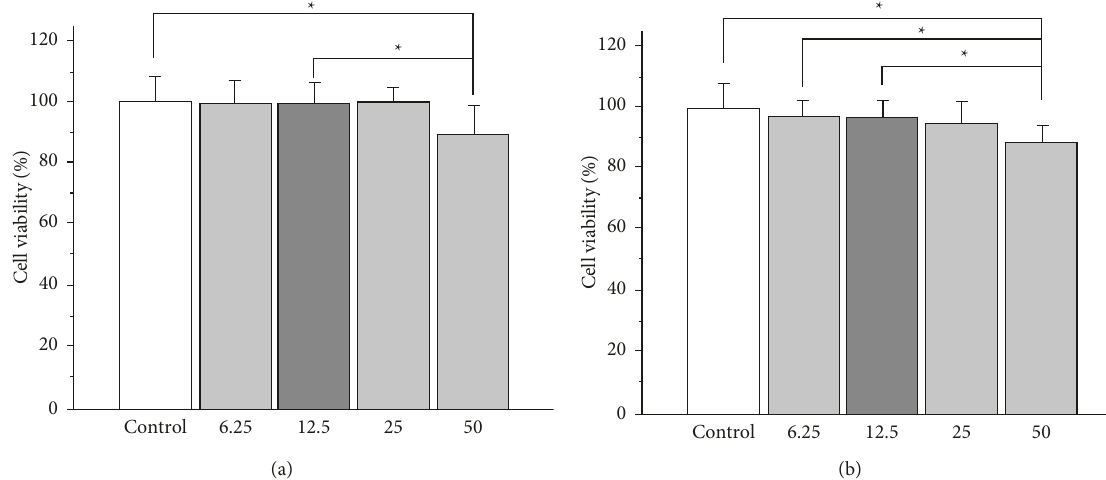
Figure 5: Percentage of cell viability of hydrogels of (a) polyacrylamide and (b) PAAm/polyaniline on the normal cell line L–929 (normal mouse subcutaneous tissue). The error bar represents the standard deviation ( n ≥